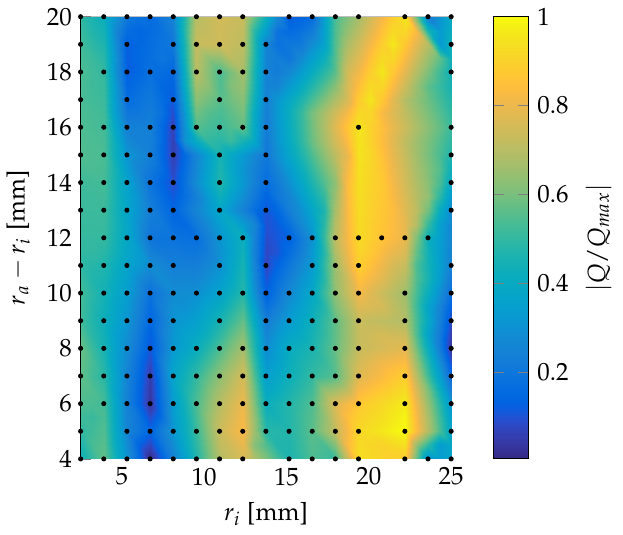
Figure 18. Relative generated electrical charge of a ring sensor with different geometries and 0.2 mm thickness for a 5 mm diameter actuator and a 5 mm steel